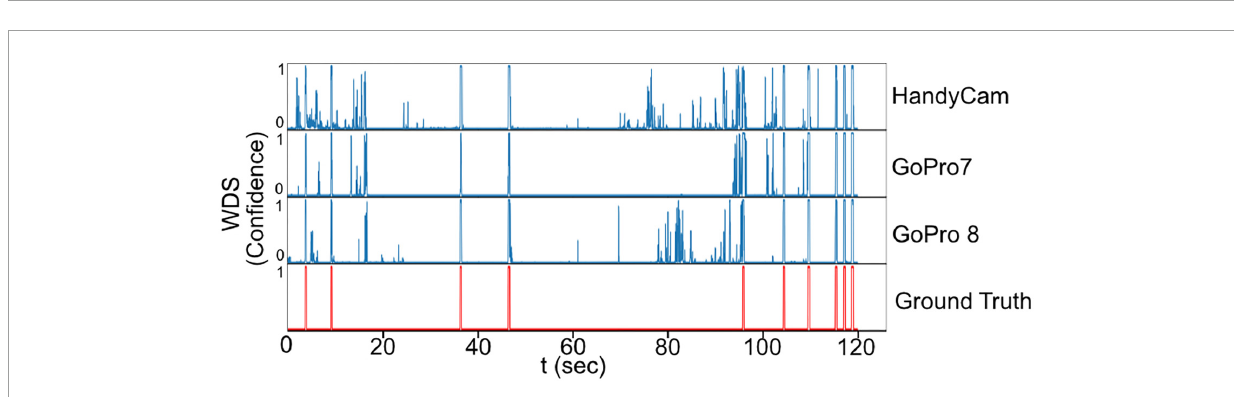
encode useful semantic features at different scales and